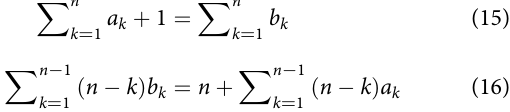
FIGURE 2 | Five-story steel building .